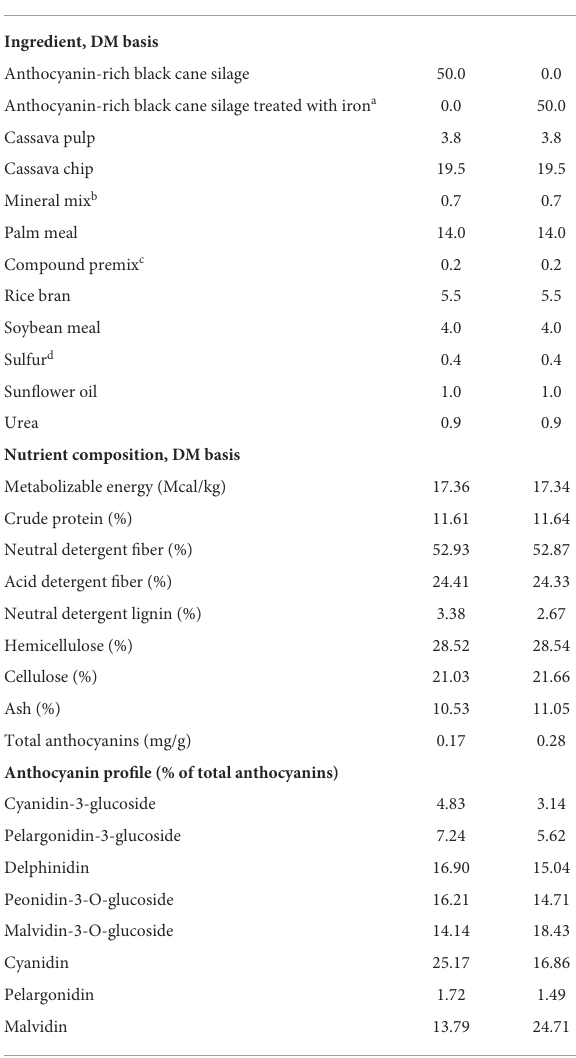
TABLE 1 Ingredients and nutrient composition of experimental